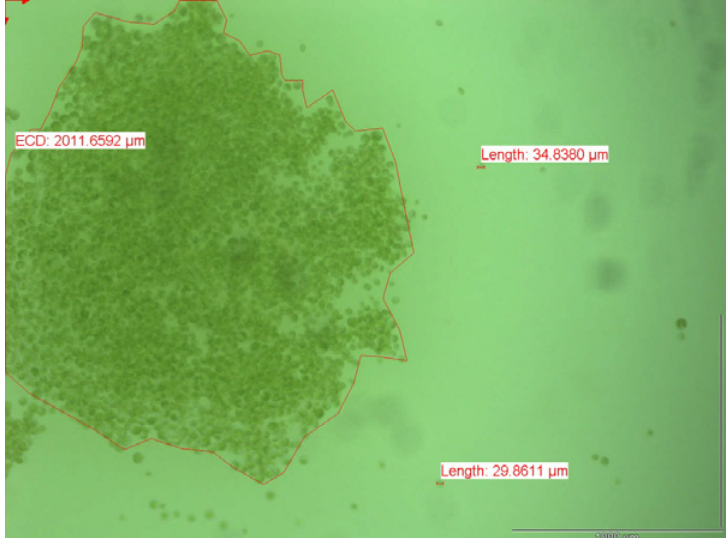
Figure 7. Microscopic photos for FWM-CV colonies before ultrasound